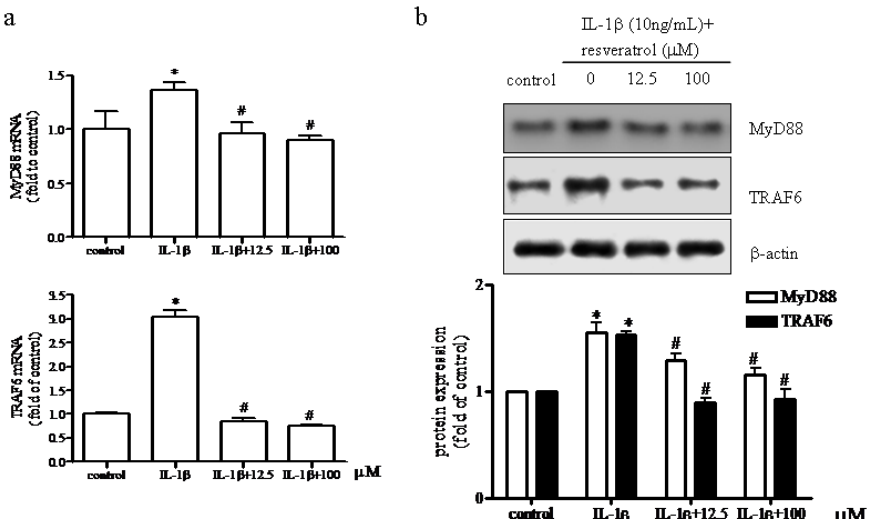
Figure 5. Effect of resveratrol on the TLR4 signaling pathway in human chondrocytes. The effect of resveratrol on ( a ) MyD88 and ( b ) TRAF6 mRNA and protein expression was assessed in serum-starved (0.5% FCS) articular chondrocytes treated with 10 ng/mL IL-1β for 1 h before being treated with either 12.5 or 100 µM resveratrol for 24 h. The relative expression levels of MyD88 and TRAF6 mRNA were determined by real-time RT-PCR. p < 0.05, * vs. control, # vs. IL-1β. After incubation of chondrocytes in the presence or absence of resveratrol as described above, the relative amount of MyD88 and TRAF6 were determined by western blot